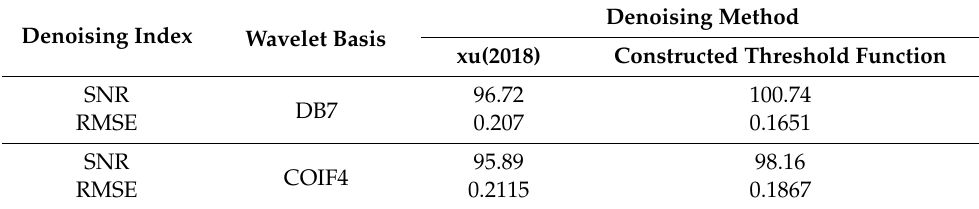
Table 4. Constructed wavelet threshold denoising